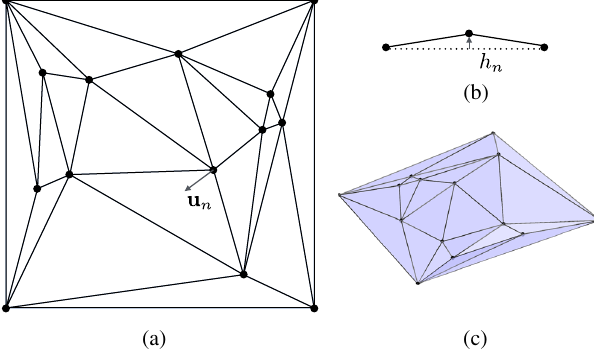
FIG. 2. (a) An origami in the unfolded state; the vector u represents the in-plane displacement of vertex n . (b) A cross- sectional side view near vertex n ; the scalar h displacement of vertex n . (c) A small deformation of this origami away from the unfolded